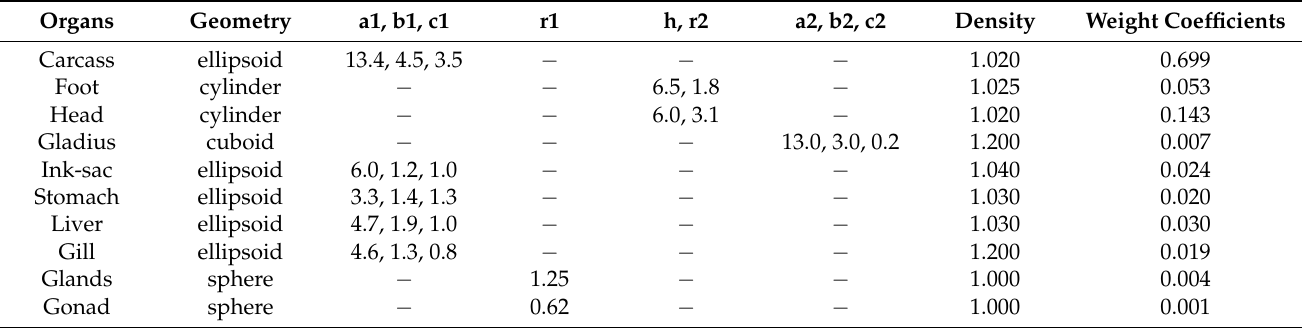
Table 2. Geometry, mass, and density information of O. bartramii .